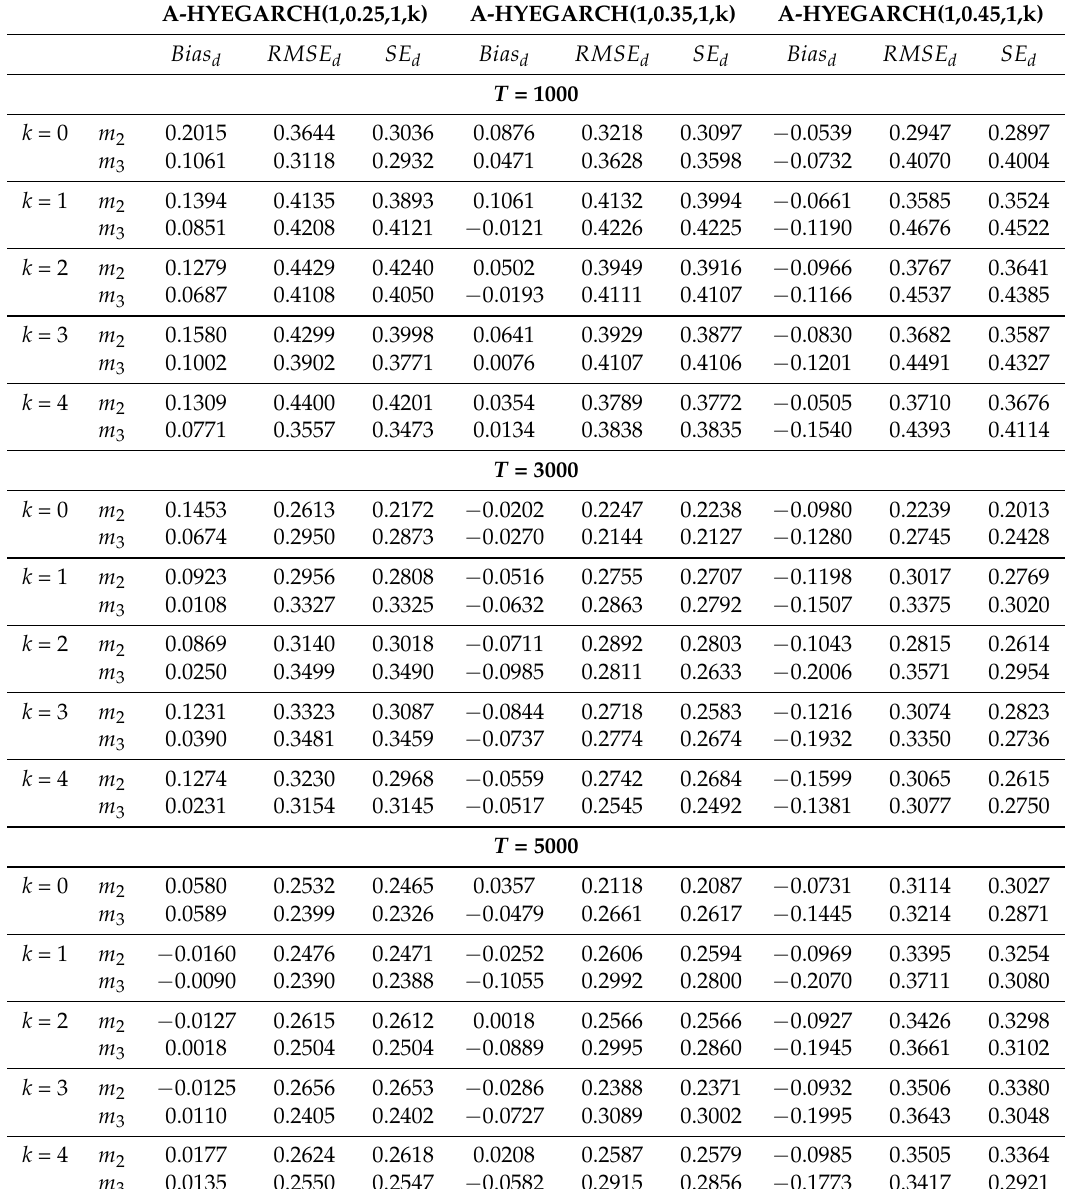
Table 5. Simulation results for estimation of A-HYEGARCH ( 1, d ,1, k ) models with various structural change